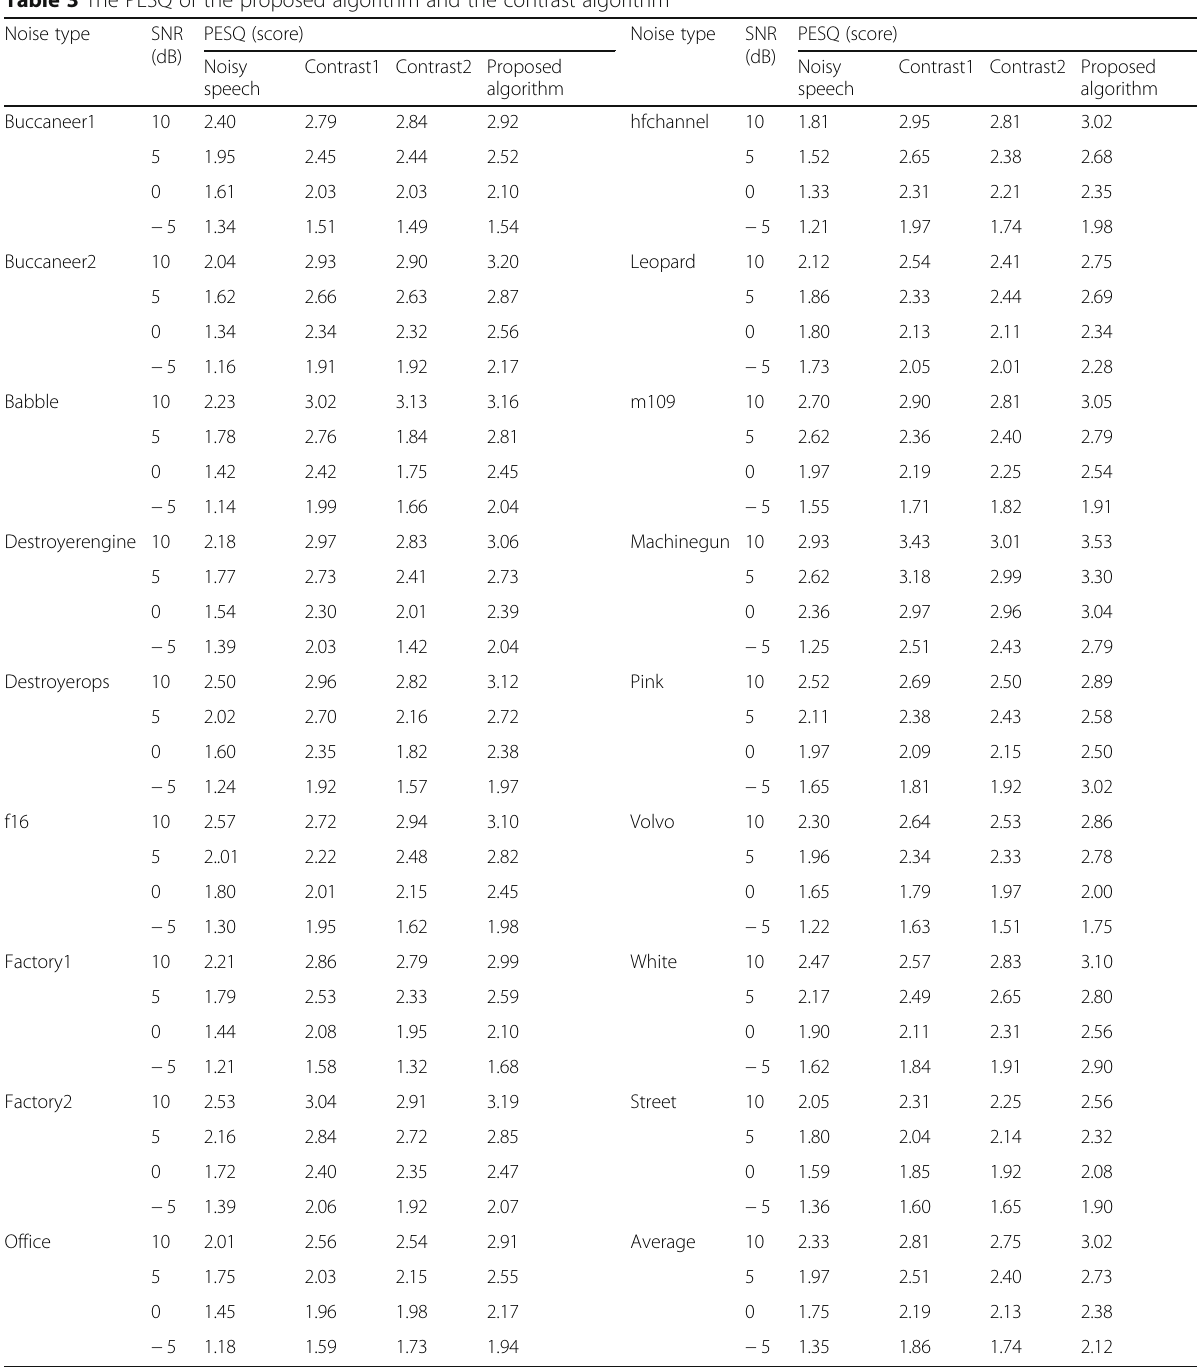
Table 3 The PESQ of the proposed algorithm and the contrast algorithm Noise type